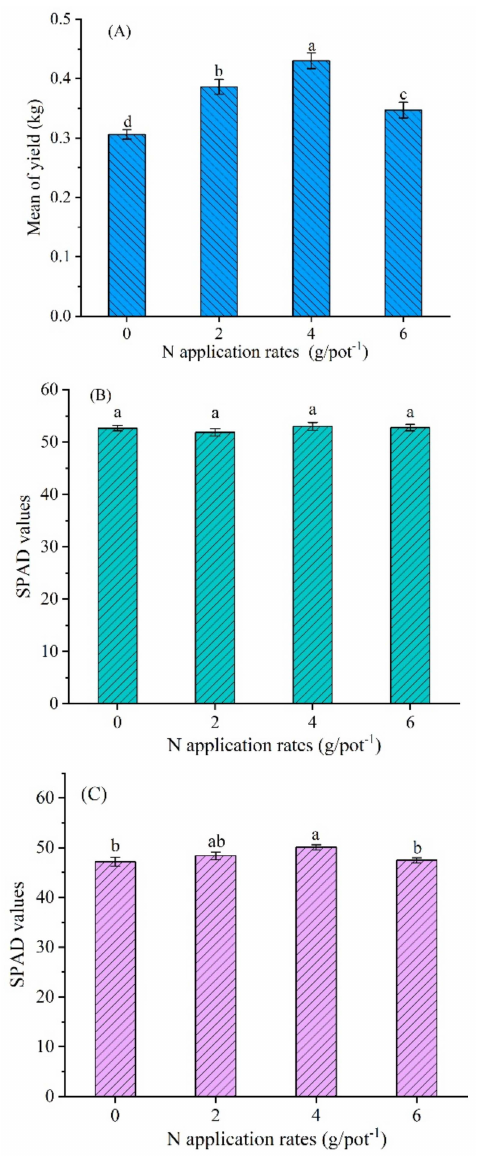
Figure 3. ( A ) The effect of the N application rate on the relative yield of potato tubers. ( B ) The effect of the N application rate on SPAD values 35 days after the emergence of potatoes. ( C ) The effect of the N application rate on SPAD values 50 days after the emergence of potatoes. Different letters represent significant differences ( p <